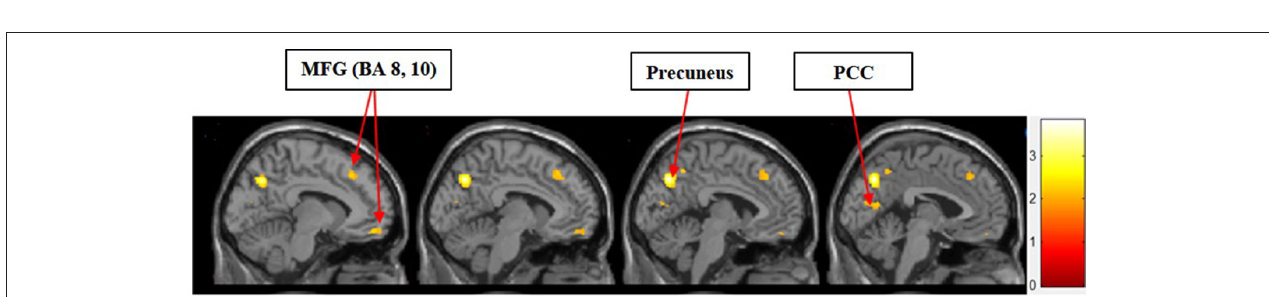
FIGURE 3 | Experiential motivation > functional motivation. The color bar reflects t -values that resulted from the contrast. The precuneus, PCC, MFG (Brodmann area 9), caudate, putamen, parahippocampal gyrus, amygdala, and IFG showed significantly higher activation while processing products with experiential motivation as compared to functional motivation.